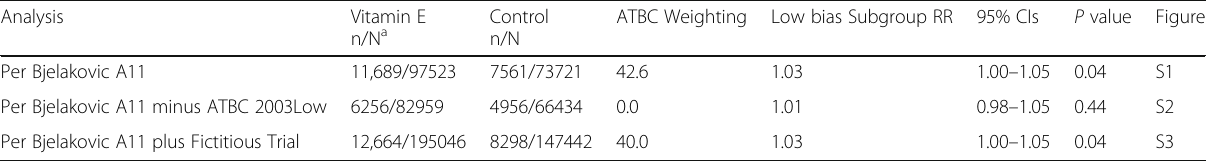
Table 2 Sensitivity analyses of Risk Ratio (RR) low risk of bias data subset by a) removing ATBC study, and b) adding fictitious dataset to original low risk of bias